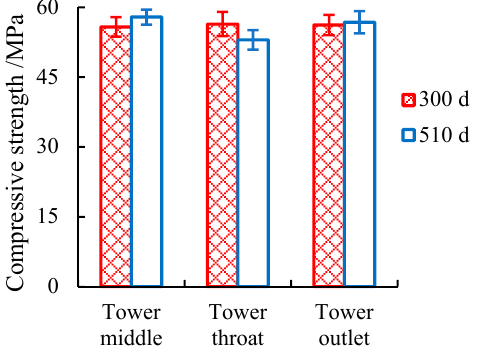
Figure 6. Compressive strengths of in situ specimens at different locations.